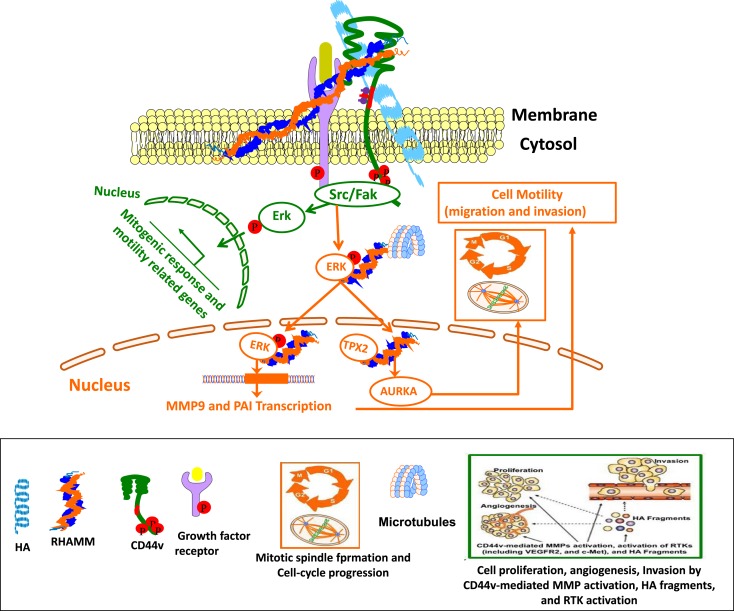
Cross-talk between CD44 and RHAMM interaction with HA affects physiological and cellular functions. Green Track is for extracellular RHAMM signaling involving CD44-HA-mediated pathways. Red track is for intracellular RHAMM signaling. Studies suggest a model for functions of CD44 and RHAMM. The interaction of HA-CD44-RHAMM affects physiological and cellular functions. Cell surface RHAMM interacts with CD44, HA, and growth factor receptors (GFR) to activate protein tyrosine kinase signaling cascades that activate the ERK1/2 MAP kinase cascade in a c-Src/Raf-1/MEK-1/ERK1/2 dependent manner (depicted in green track). In the absence of intracellular RHAMM, this signaling can stimulate the transcription of motogenic effectors to regulate a mitogenic response (cell proliferation/random motility). In the presence of intracellular RHAMM (red track), MEK-1/p-Erk1/2 also binds to a number of protein partners that allows activated RHAMM to enter the nucleus to regulate functions of microtubule dynamics via centrosome structure/function, and cell cycle progression via AURKA, a targeting protein for XkIp2 (TPX2). Activated RHAMM also controls expression of genes involved in cell motility such as PAI-1 and MMP-9.